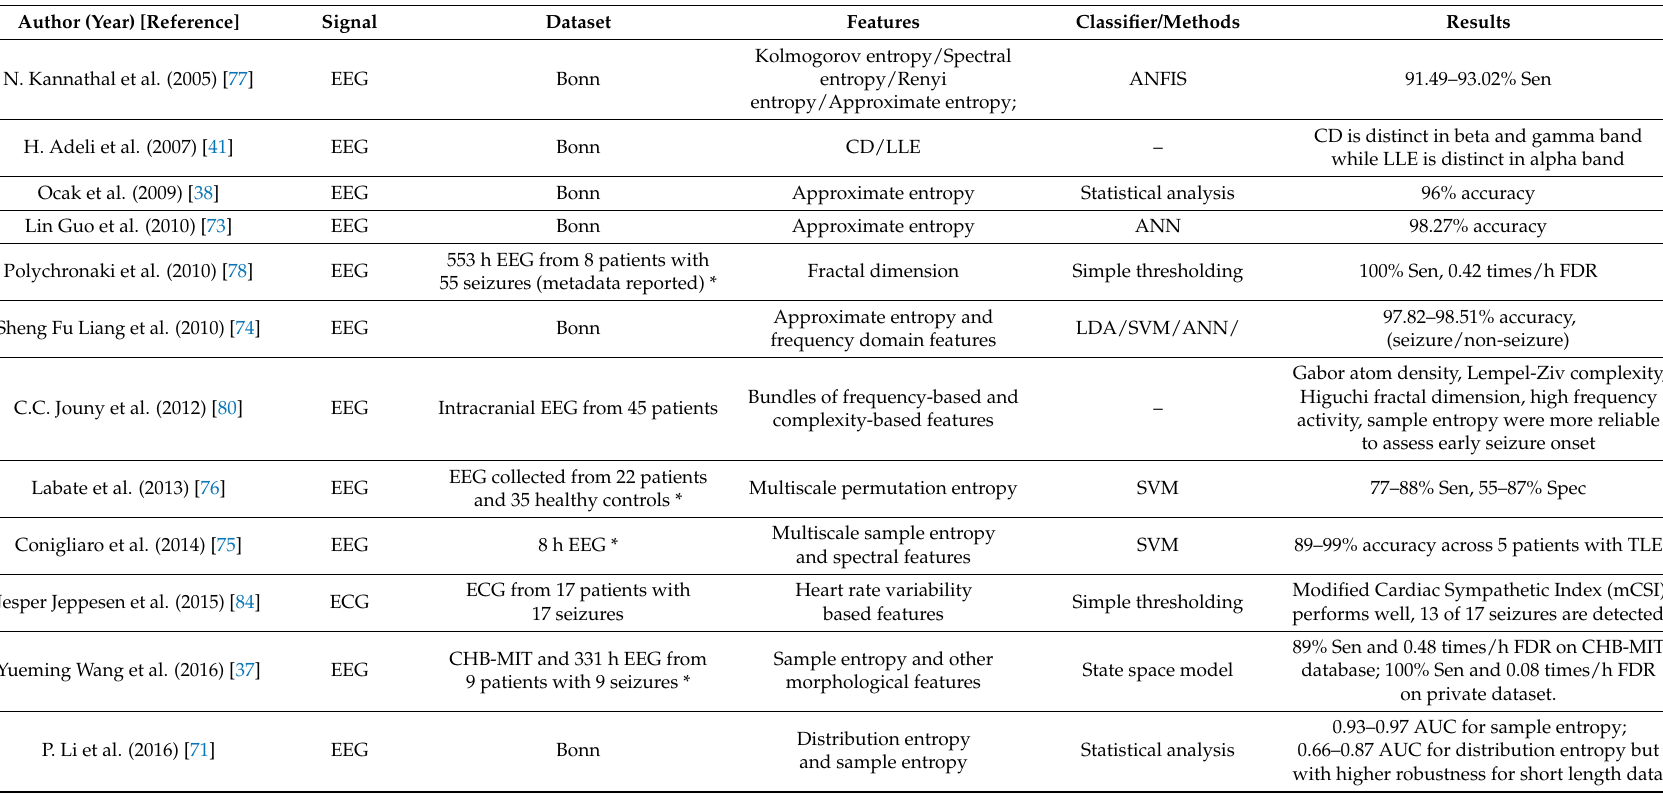
Table 2. Epileptic Seizure Monitoring using Nonlinear Dynamics (Sen: Sensitivity. Spec: Specificity. FDR: False detection rate. “*” indicates nonpublic dataset. CD: correlation dimension. LLE: largest Lyapunov exponent. ANFIS: adaptive neuro fuzzy inference